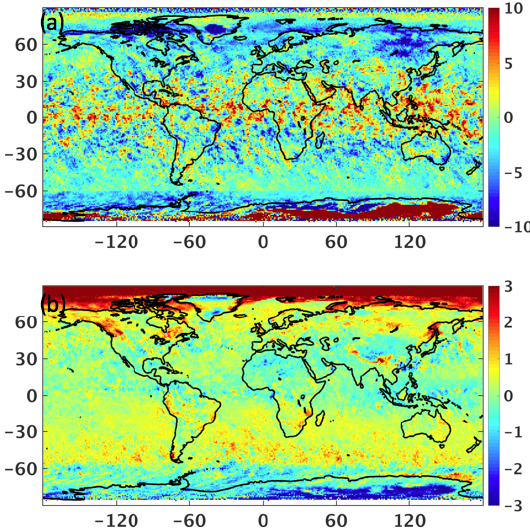
Figure 5. Cloud fraction (a) and cloud optical depth (b) differences between VIIRS and MODIS (VIIRS–MODIS) retrievals for April